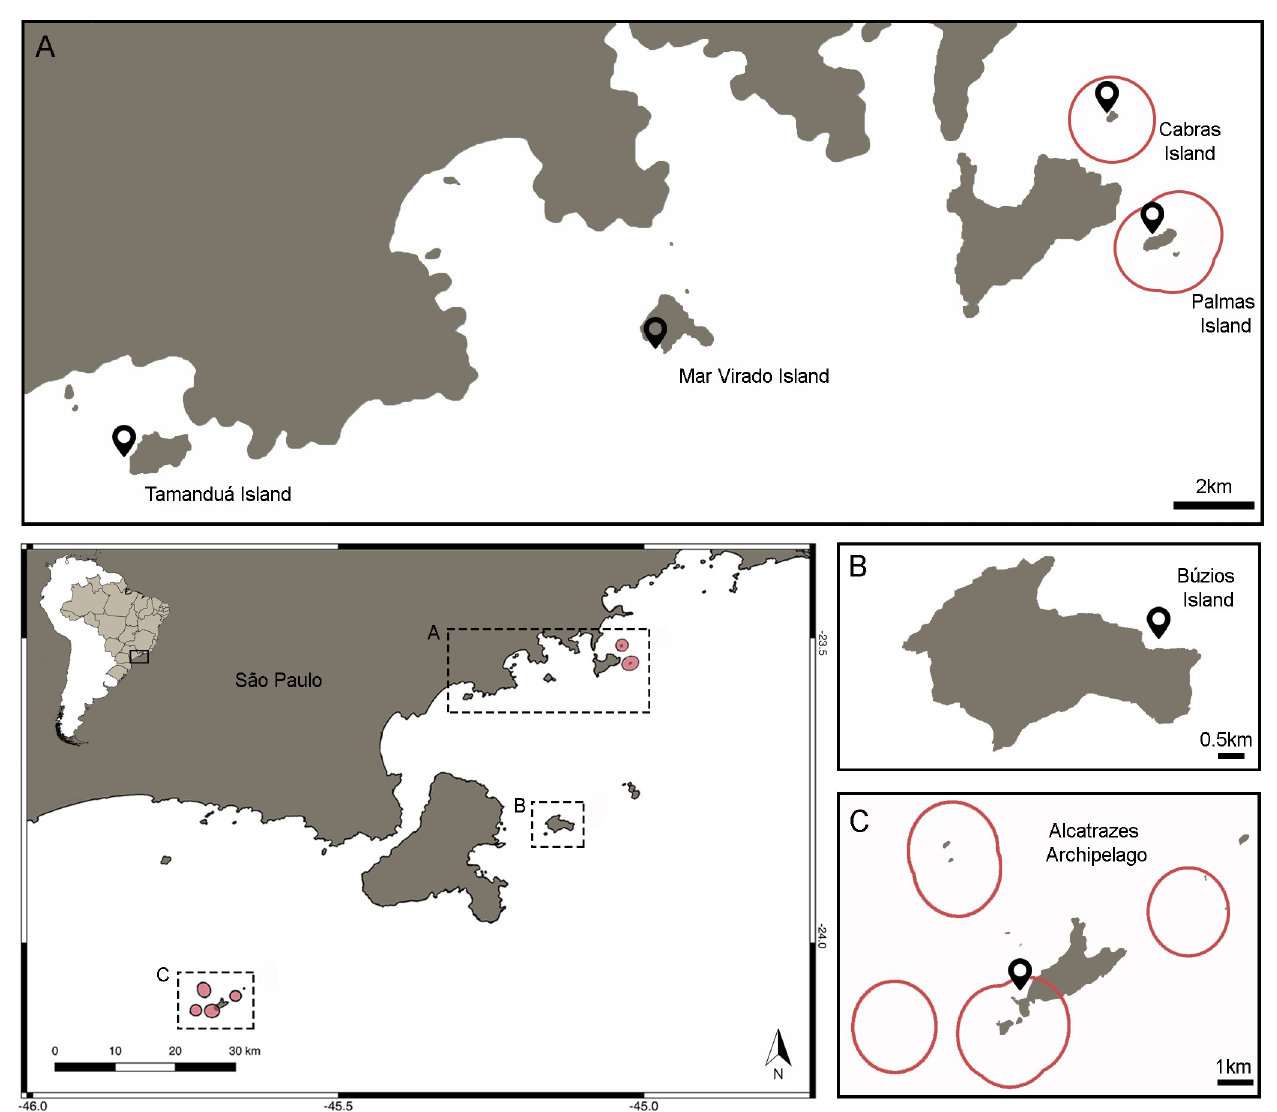
Fig 1. Map of the study area on the southeastern Brazilian coast with the no-take marine reserve Tupinamba´s Ecological Station in red. The control islands, where fishing activity is permitted (Tamandua ´ , Mar Virado and Bu´zios), are also displayed (A, B). No-take areas in detail in the islands of Cabras and Palmas (A) and in Alcatrazes Archipelago (C) with the sample sites represented by the black spots.